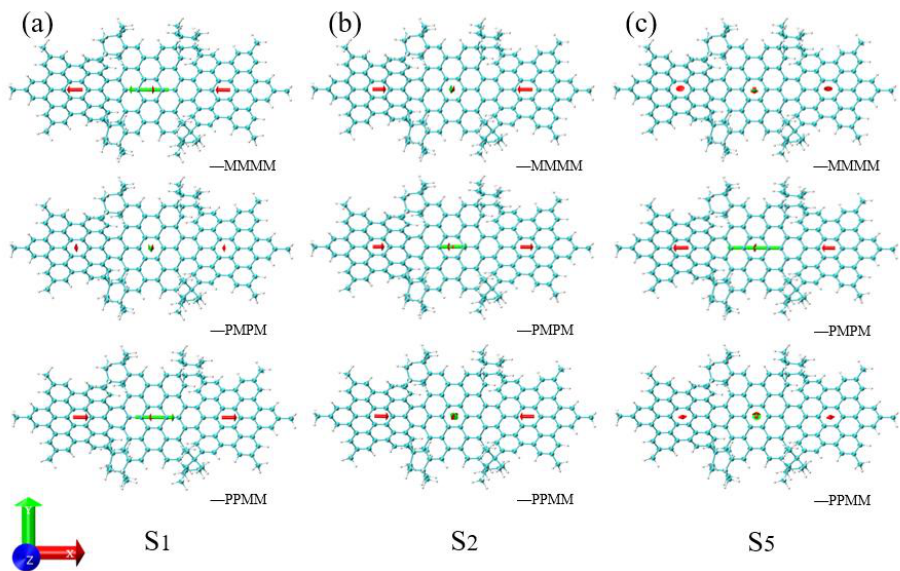
Figure 3. The TDM of S1, S2 and S5 of three isomeric molecules. ( a ) The TDM of three molecules S1, ( b ) the TDM of three molecules S2, ( c ) the TDM of three molecules S5. Red represents the TDM of the PAHs segment, green represents the total TDM of the molecule, the arrow represents the direction of the TDM and the length of the arrow represents the size of the TDM.